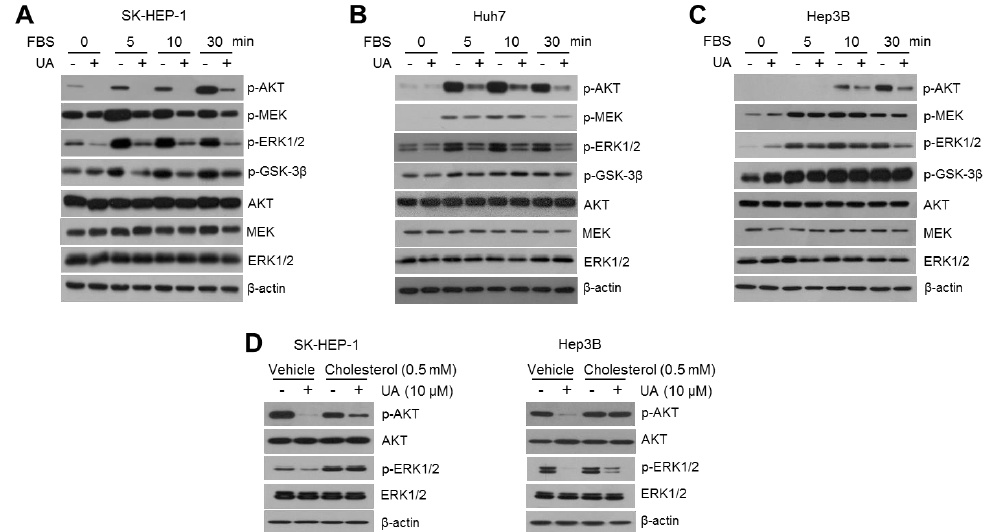
Figure 3. Ursolic acid (UA) increases the expression of cholesterol biosynthesis-related genes and enzymes in hepatocellular carcinoma (HCC) cells. ( A ) SK-HEP-1 cells were incubated, upon fetal bovine serum (FBS) starvation, for 24 h prior to UA treatment. After serum starvation, the cells incubated with DMSO or UA (20 μM) in the absence or presence of 10% FBS, as indicated. The phosphorylation of growth signaling pathway-related proteins were measured by western blotting. ( B ) Suppressive effect of UA on growth signaling measured in Huh7. ( C ) Suppressive effect of UA on growth signaling measured in Hep3B. ( D ) SK-HEP-1 and Hep3B cells were incubated for 2 h with or without 0.5 mM of water-soluble cholesterol prior to UA treatment, and cells were then further incubated with DMSO or UA (20 μM) for 24 h. Phosphorylation of AKT and ERK1/2 was measured using western blotting.